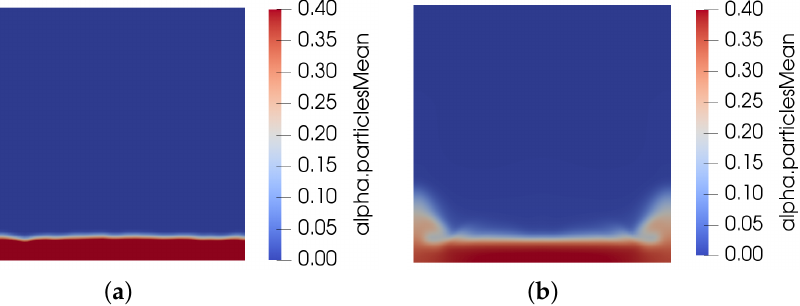
Figure 5. Different modelling techniques for vibration: ( a ) with gravity body force and ( b ) with wall-normal heat flux.